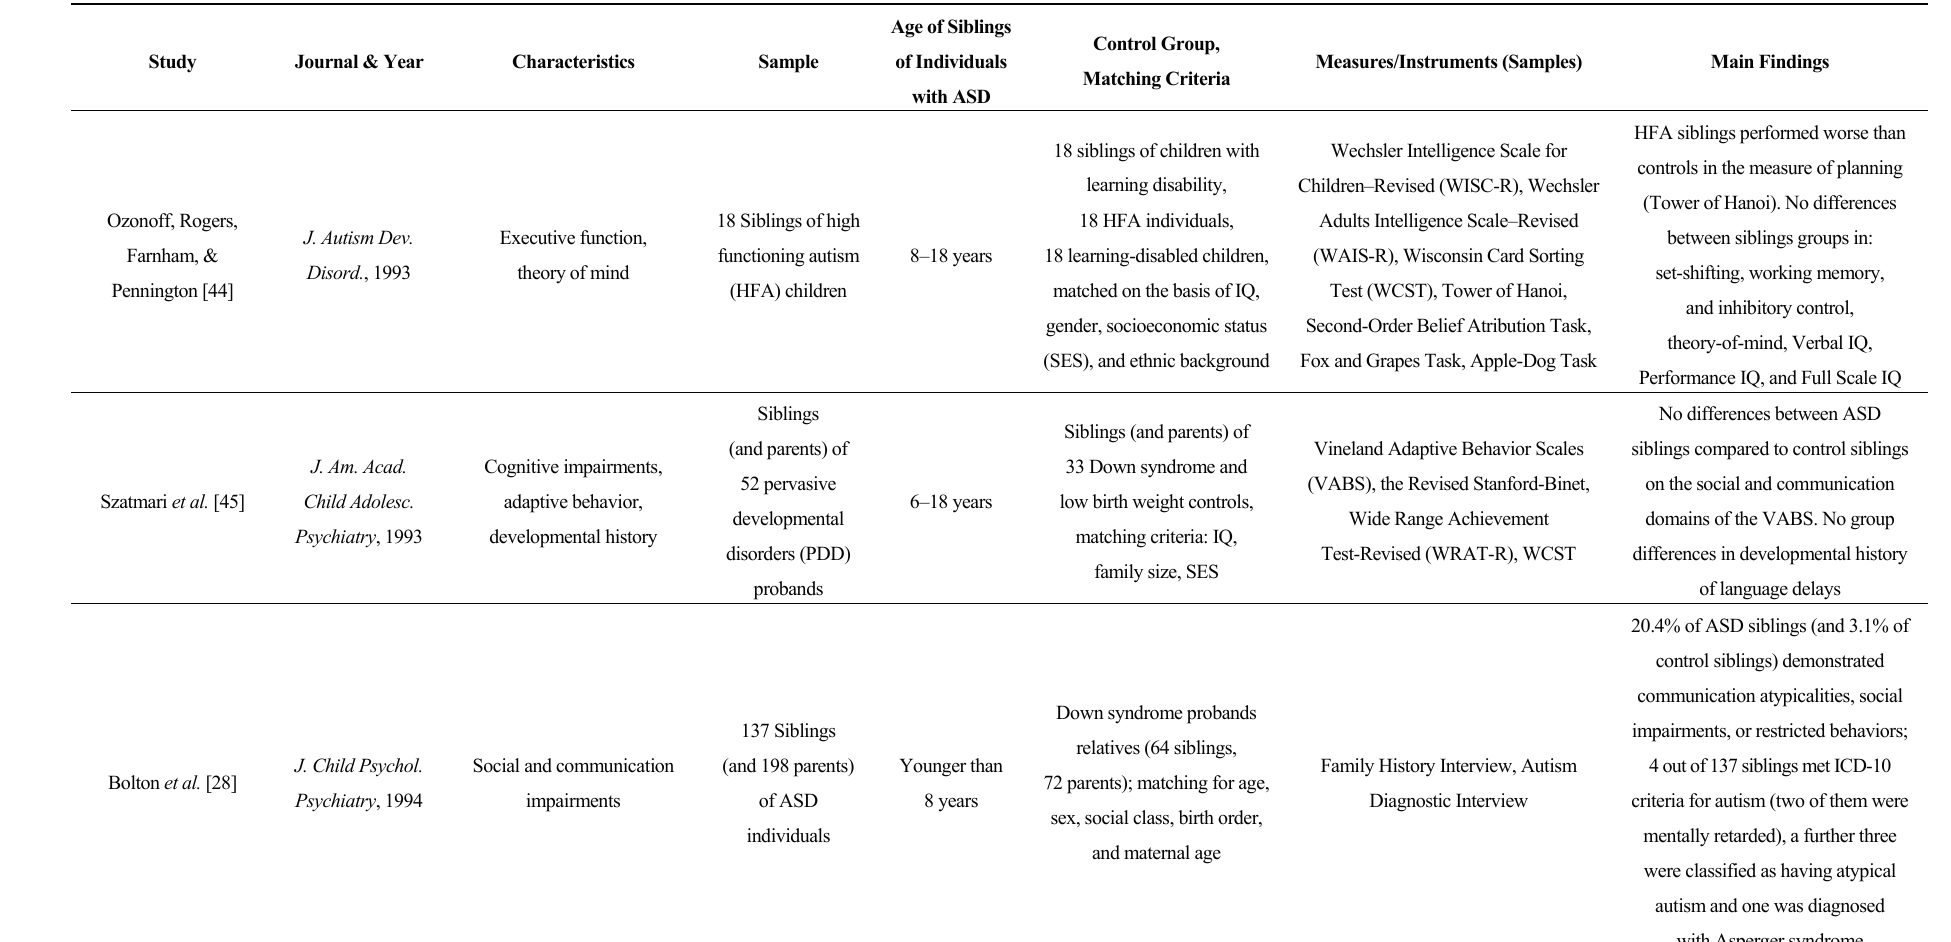
Table 1. Social communication, language, and cognitive BAP characteristics in siblings of individuals with